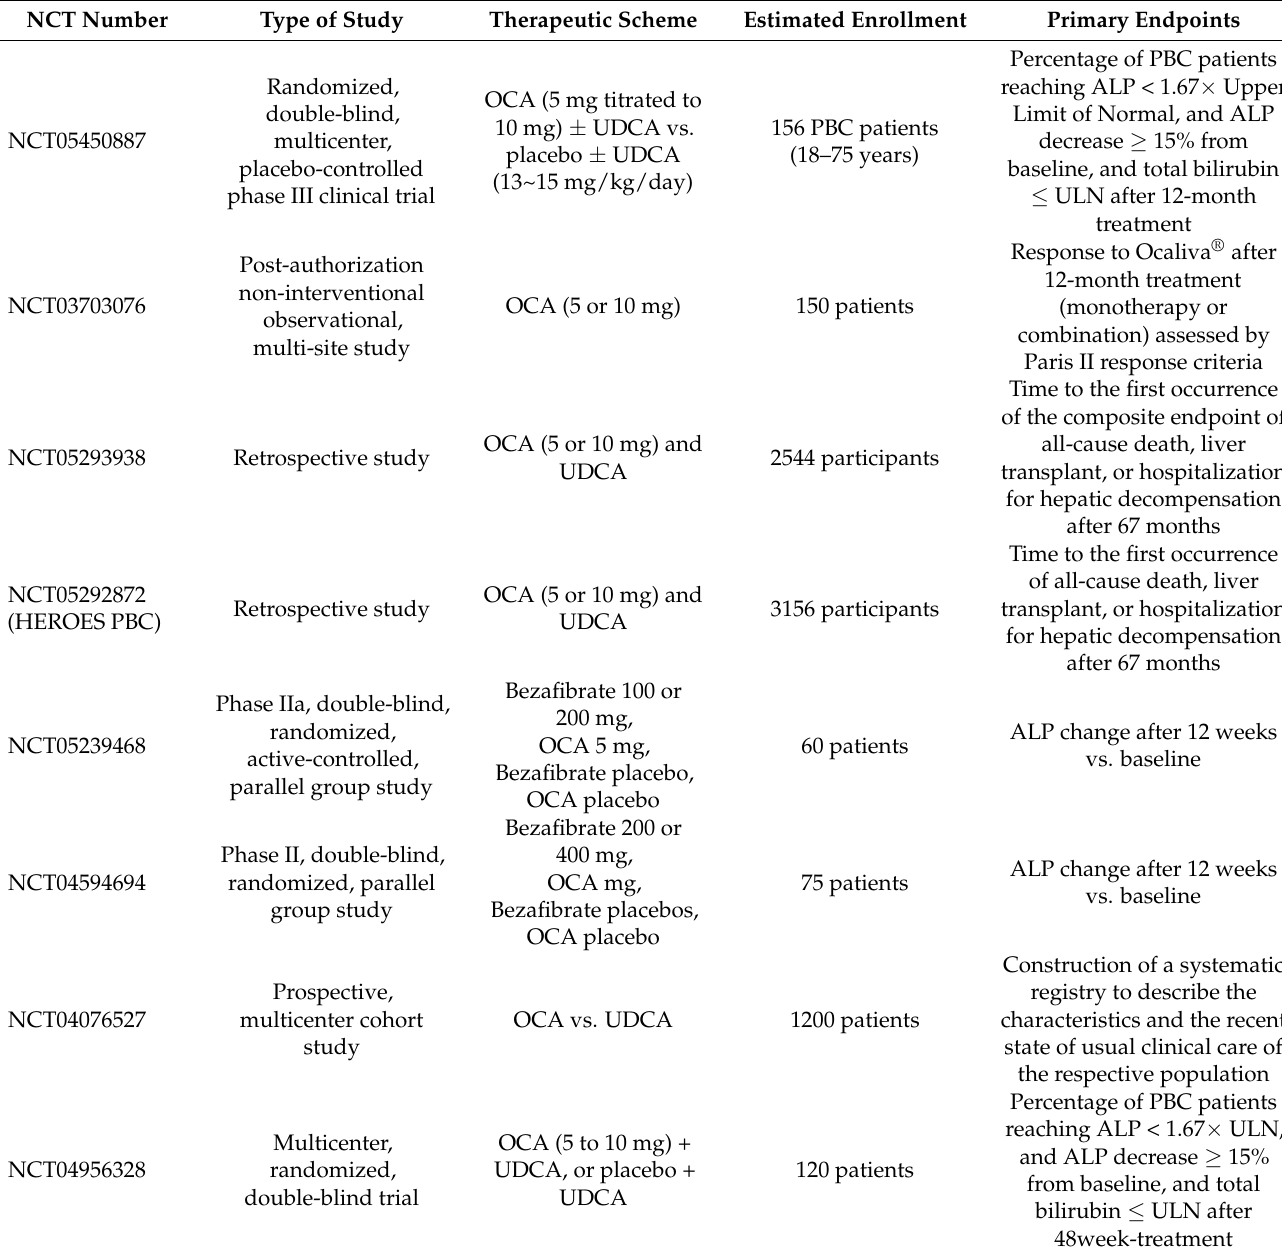
Table 2. Ongoing clinical trials recruiting patients for post-registration efficacy